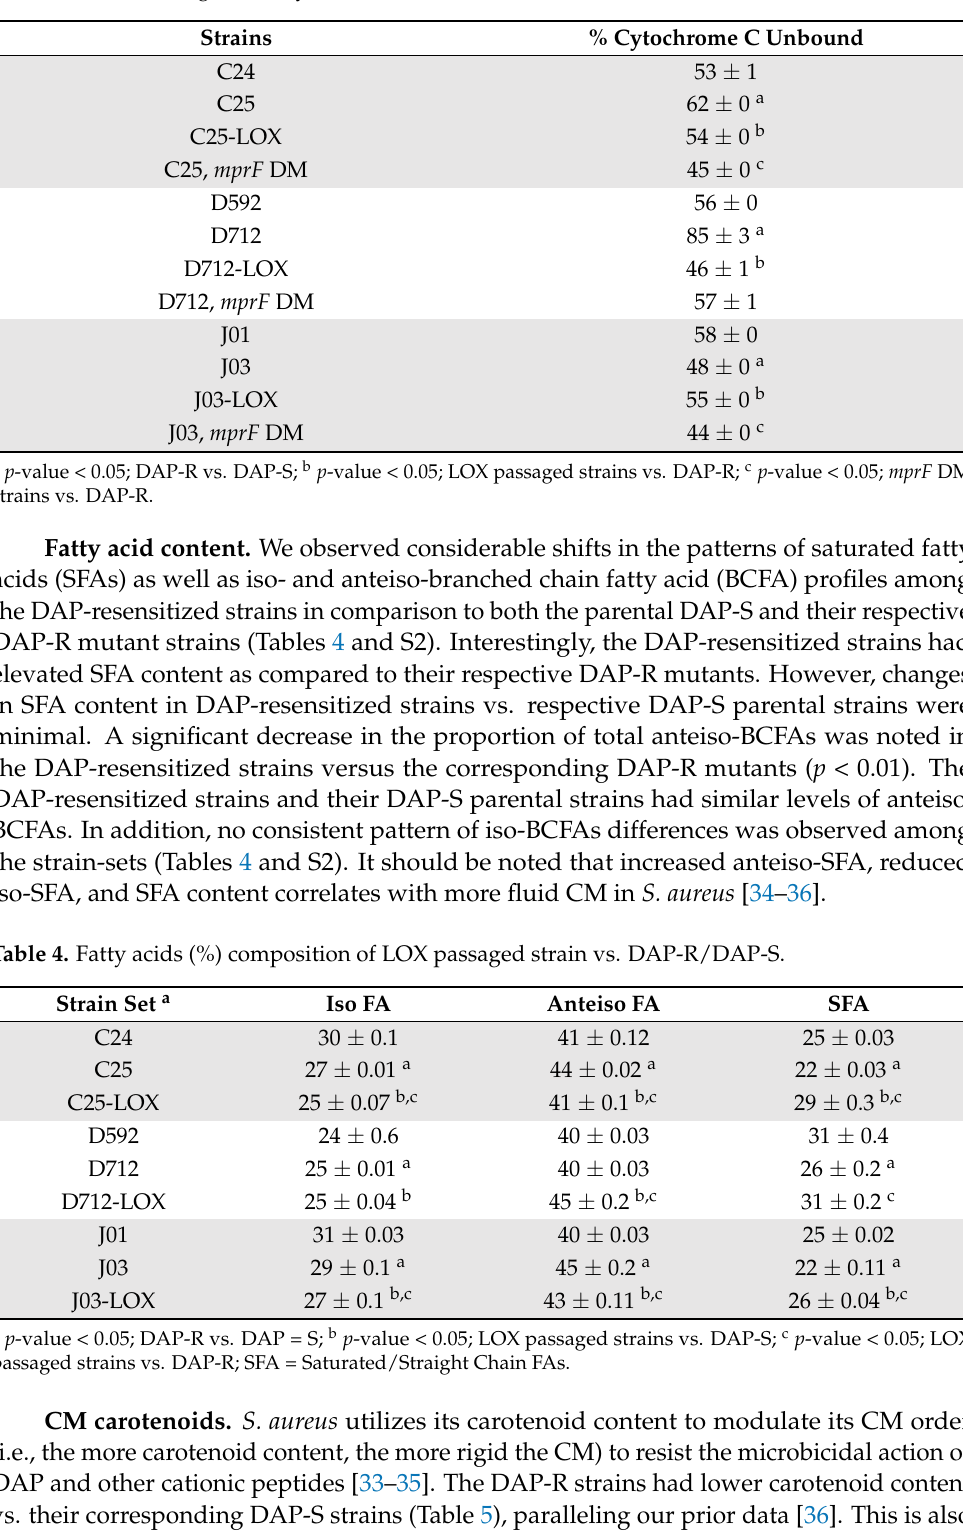
Table 3. Surface charge of study strains.